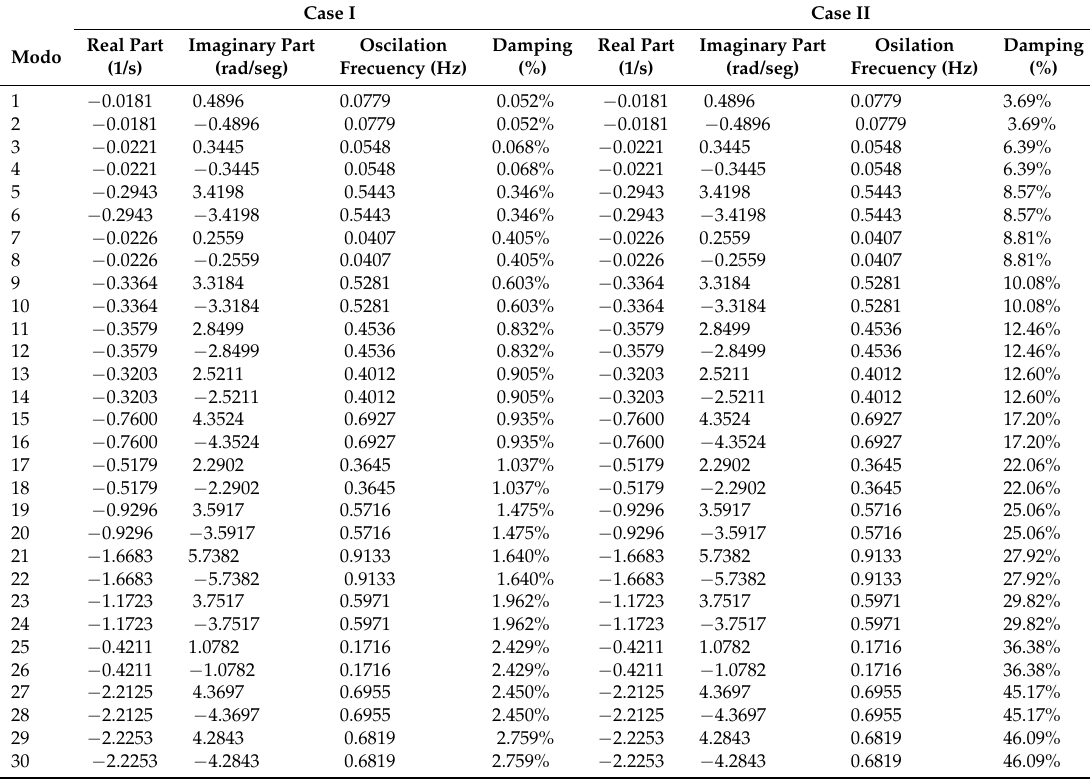
Table 12. Eigenvalues system IV.